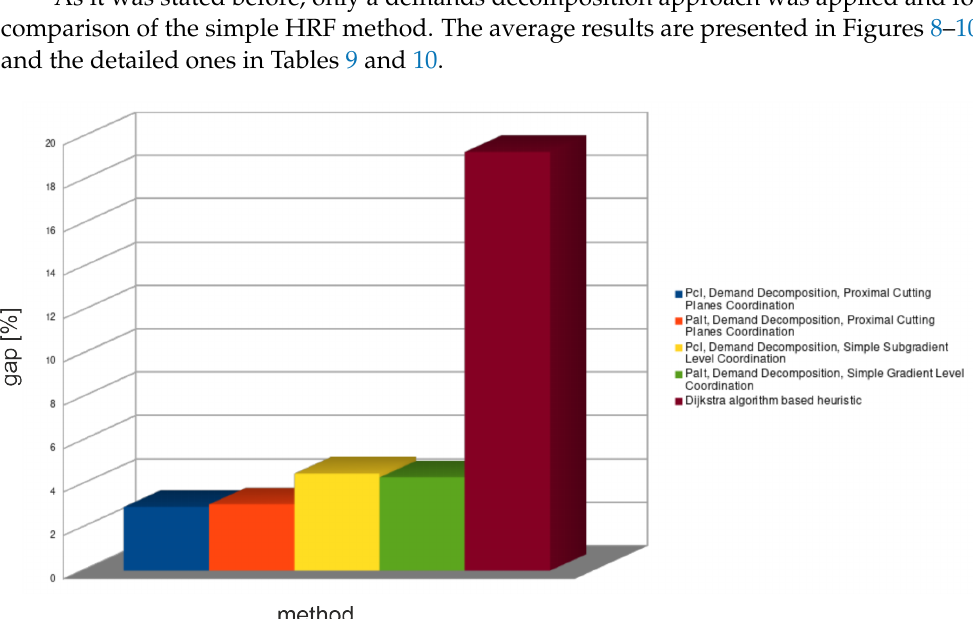
Figure 8. Average lower bound relative gap for all decomposition methods—large